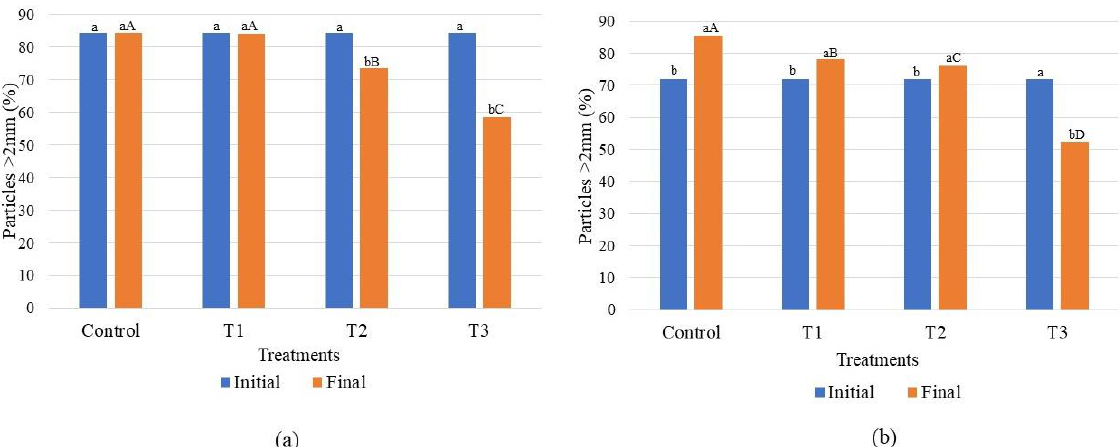
Figure 2. Comparison of the percentages of (a) hemic and (b) sapric particles > 2 mm in all treatments between the initial and final weeks of the 17-week growing period. Capital letters indicate the mean separation among treatments, while lowercase letters refer to mean separation within treatments using Tukey at